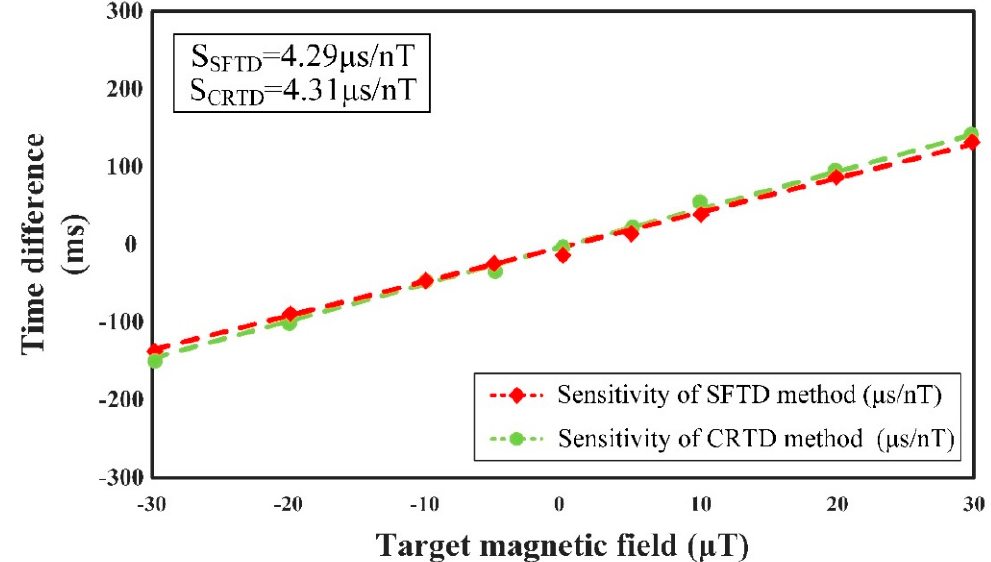
Figure 8. Sensitivity of RTD fluxgate sensor in different methods (SFTD method in red dashed line with rhombus markers and CRTD method in green dashed line with circular markers), in which the frequency and the amplitude of the driving signal are 20 Hz and 1 mA, respectively.